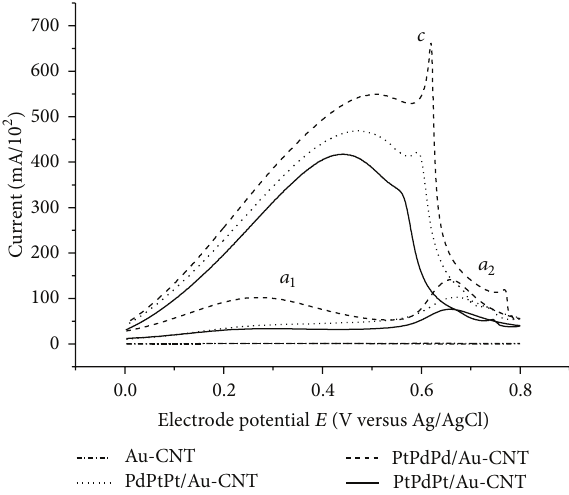
Figure 4: Cyclic voltammograms recorded in 2 MHCOOH + 1MH 2 SO 4 solution at Au-CNT, PdPtPt/Au-CNT, PtPdPd/Au-CNT, and PtPdPt/Au-CNT in the potential range 0.00 to 0.80 V at a scan rate 0.05 V ⋅ s −1